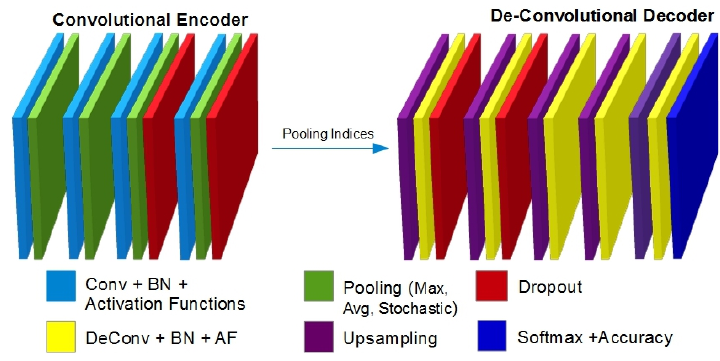
Figure 3. Architecture of the Base Model for Semantic Segmentation (BMSS). Table 1. BMSS. ELU, Exponential Linear